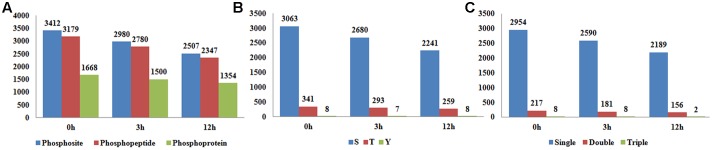
(A) The number of identified phosphosites, phosphopeptides, and phosphoproteins in samples at 0, 3, and 12 h after brassinosteroid (BR) treatment. (B) The counts of phosphosites in serine, threonine and tyrosine. (C) The counts of phosphopeptides carrying single, double, and triple phosphorylation modifications.